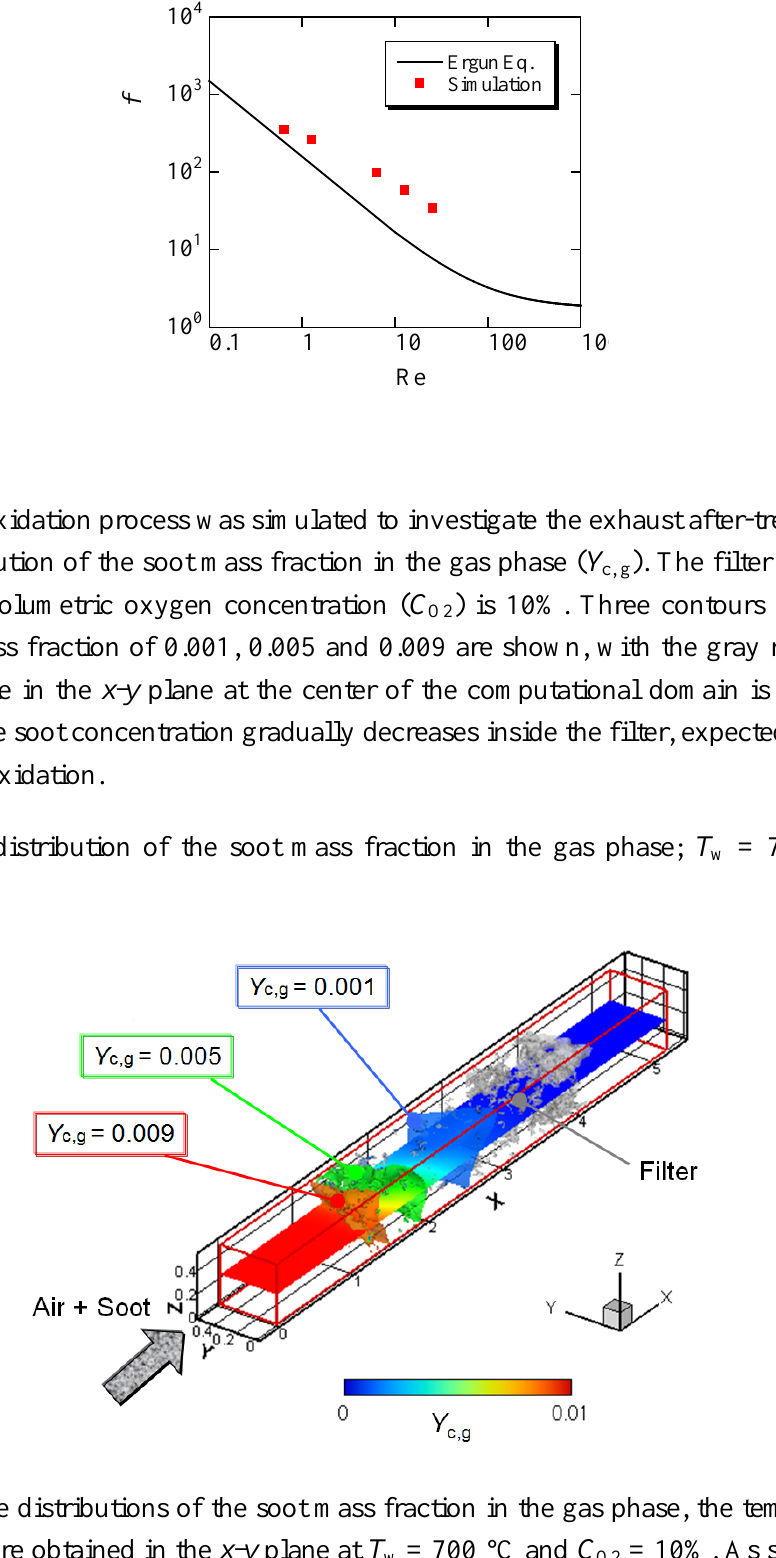
Figure 7. Variations of the friction factor with the Reynolds number (Re) are shown in the simulation, compared with the Ergun equation.